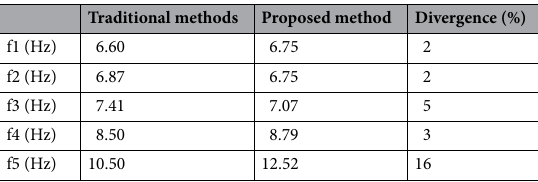
Table 2. Results of the modal analysis of a five-girder deck.